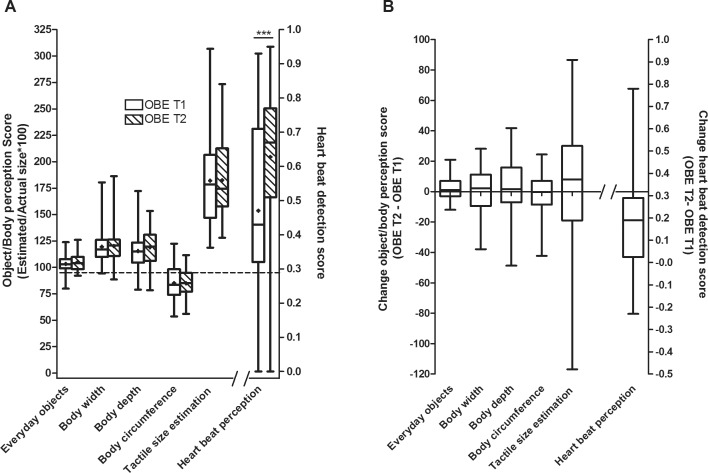
Perception Scores of body perception in obese children (OBE) before (T1) and after weight loss (T2).A: The perception scores of everyday objects, body width, body depth, body circumference, tactile size estimation and heartbeat detection are displayed as box-whiskers with a cross, the latter depicting the mean. Except for the heartbeat detection score, values below 100 indicate an underestimation and values above 100 indicate an overestimation in terms of percent of the actual size. For the heartbeat detection, a score of 1 indicates absolute accuracy of heartbeat detection and the minimum score of 0 indicates that no heartbeat was perceived. The mean±standard deviation of the perception scores were as follows: Everyday objects–T1: 103±08, T2: 105±08; Body width–T1: 120±15, T2: 120±14; Body depth–T1: 115±20, T2: 119±16; Body circumference–T1: 85±16, T2: 85±12; Tactile size estimation–T1: 182±41, T2: 183±35; Heartbeat detection–T1: 0.47±0.26, T2: 0.63±0.21. Due to multiple testing the p-values were false discovery rate (FDR)-adjusted. FDR values <0.05 were considered as statistically significant. *** indicates FDR<0.001. B: The change values of the perception scores in OBE are presented as box-whiskers.